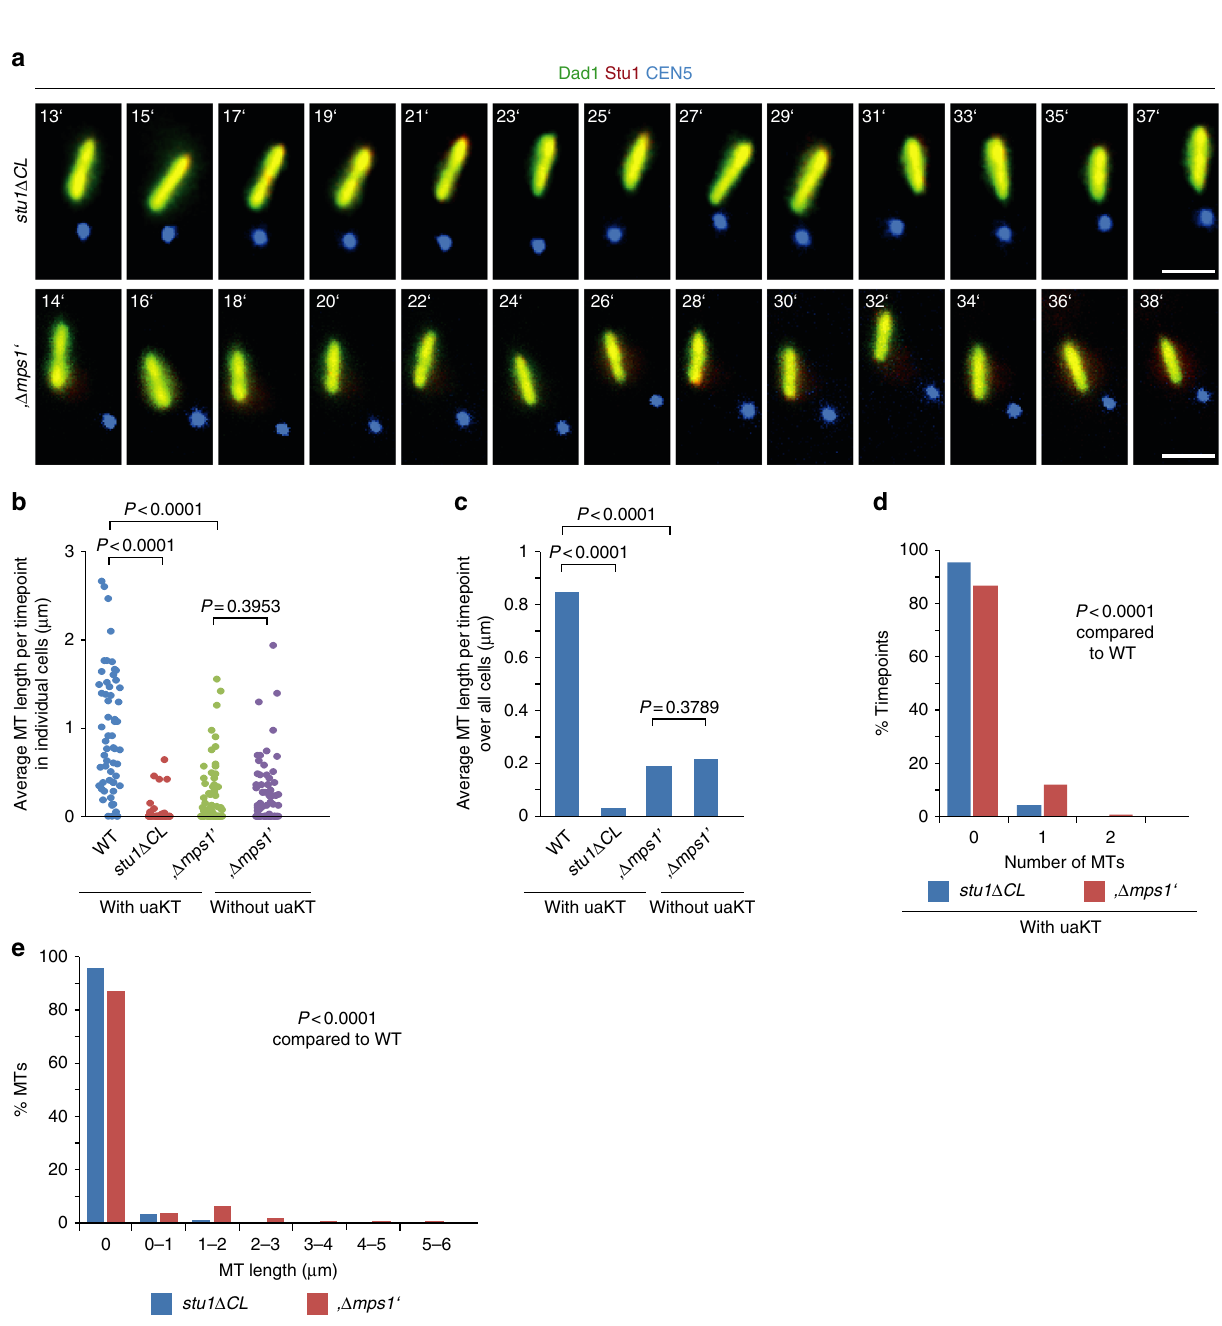
plus end till the KT was close to the SPB (Fig. 7c). In 30% of the events, all detectable Stu1 colocalized with the KT representing either KT- or MT-associated Stu1. In the vicinity of the SPB, Stu1 usually overtook and/or dissociated mostly from the KT, allowing Stu1 to stabilize the spindle before the KT achieved bipolar attachment.